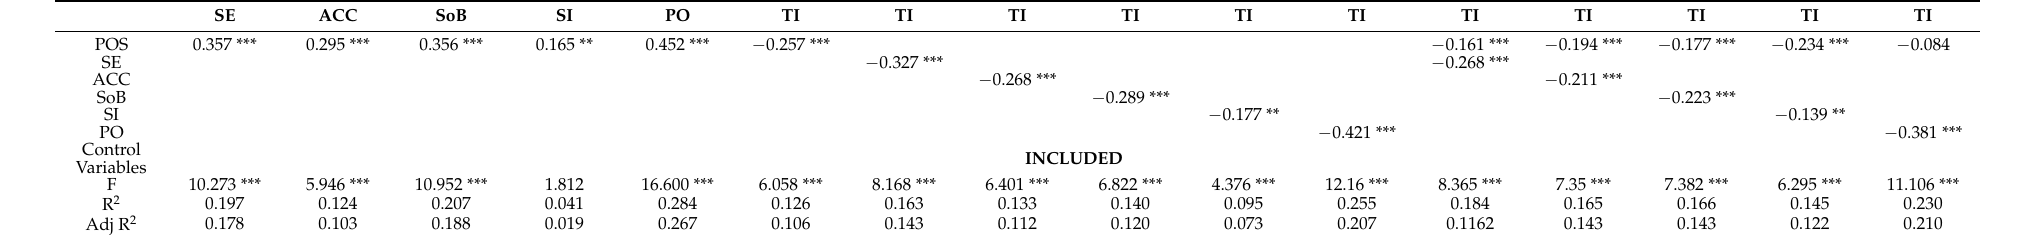
Table 5. Regression